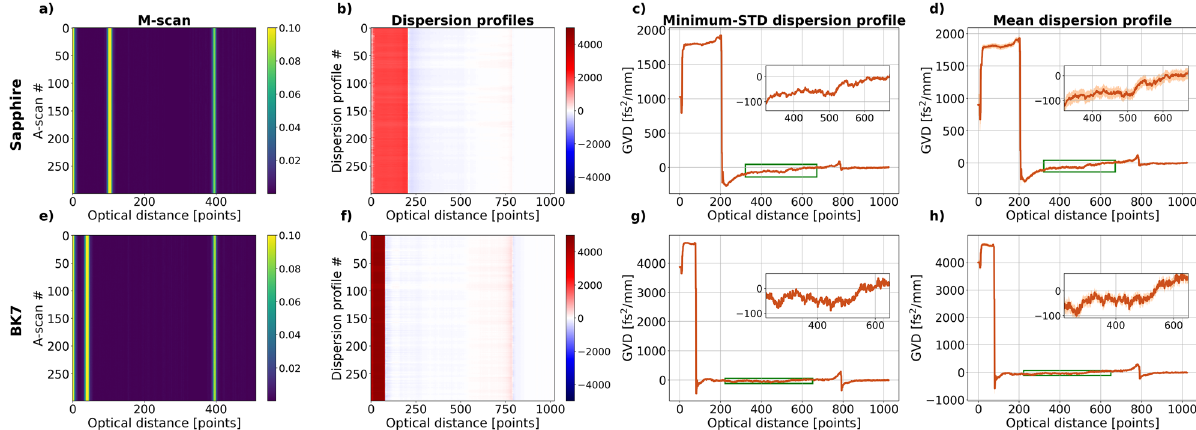
Figure 6. Sapphire and BK7: ( a , e ) an M-scan containing 300 A-scans with the autocorrelation peaks removed, ( b , f ) dispersion profiles corresponding to each A-scan in the M-scan, ( c , g ) dispersion profiles for which the standard deviation (STD) calculated from the GVD values in the green rectangle is the smallest, the inset is a closeup of the area in the plot marked with the green rectangle, ( d , h ) is the dispersion profile obtained by taking the mean of all the dispersion values, again the inset is a closeup of the area marked with the green rectangle. The twice bigger length of the x axis in the dispersion maps and dispersion profiles is a by-product of the FFT stack